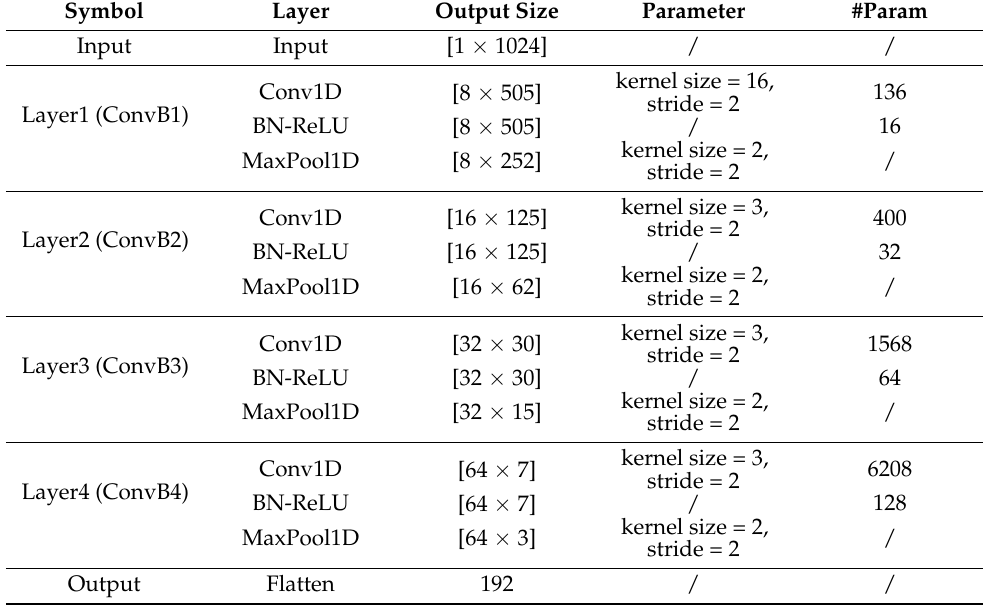
Table 4. Structure of the feature